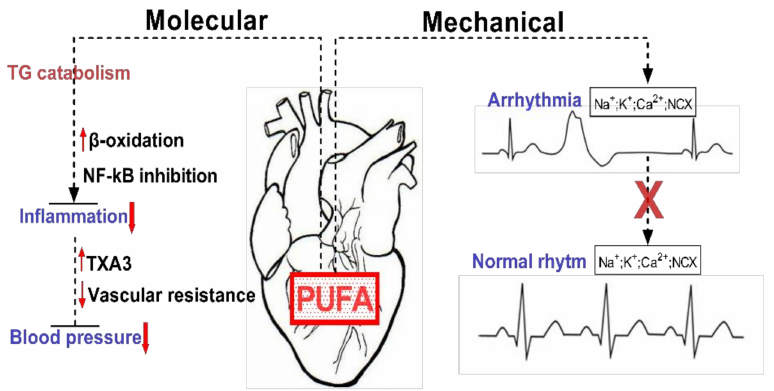
Figure 2. Exemplification of the molecular and mechanical implications of PUFAs in cardiac function. PUFAs are involved in reducing tissue inflammation by inducing TG catabolism via increased β - oxidation and NF-kB inhibition. Mechanically they can restore cardiac rhythm by inhibiting ion channels and